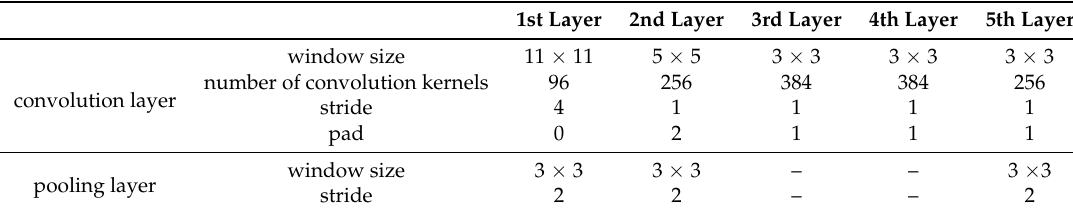
Table 3. The parameters of each layer in the sceNet network.